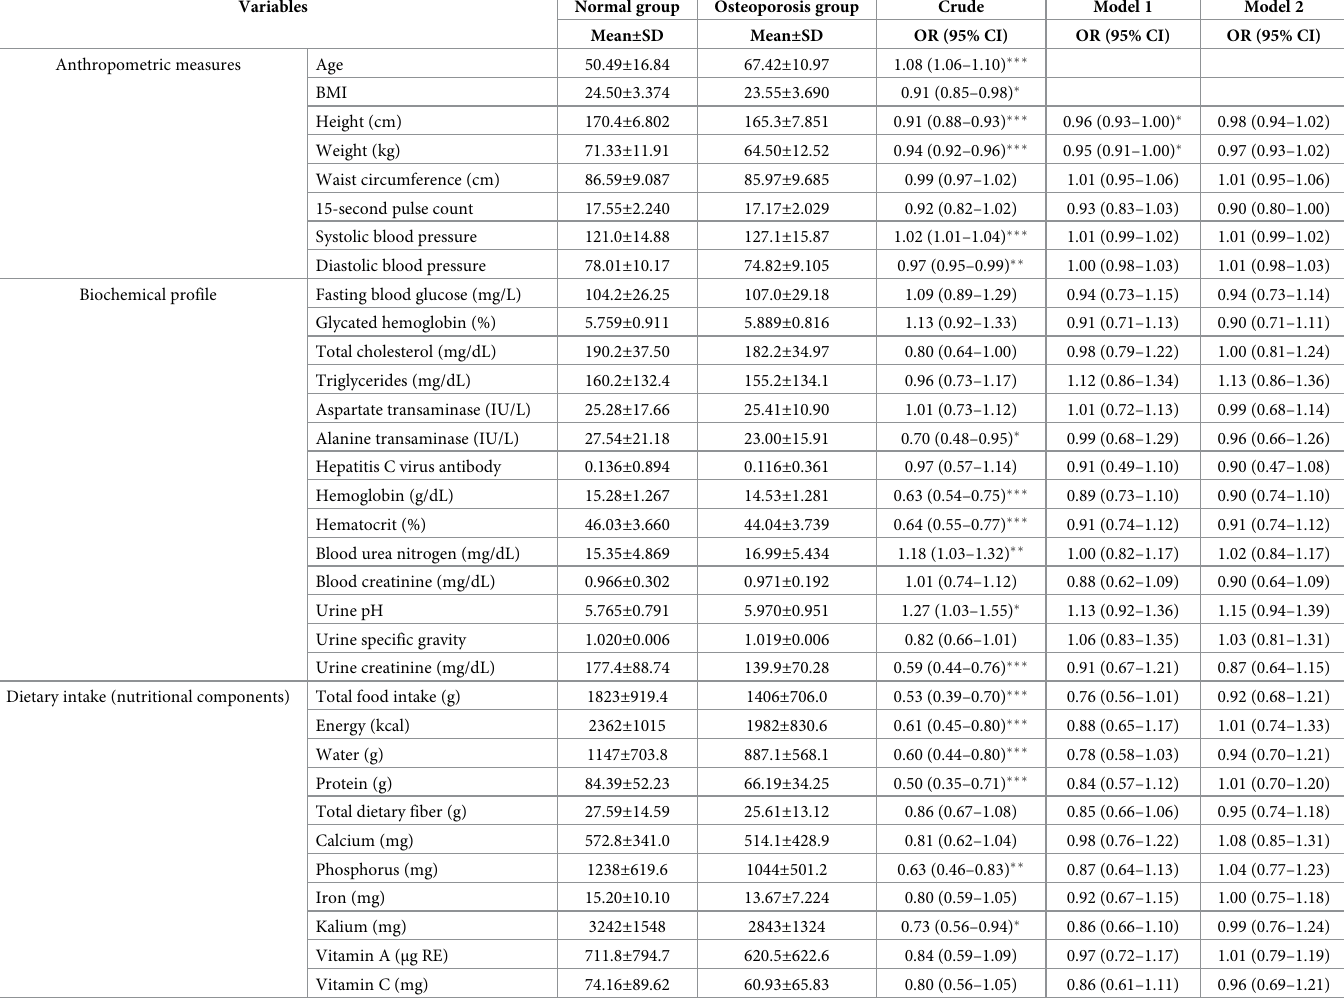
Table 3. Association of osteoporosis with anthropometric measures, biochemical profile, and dietary intake in